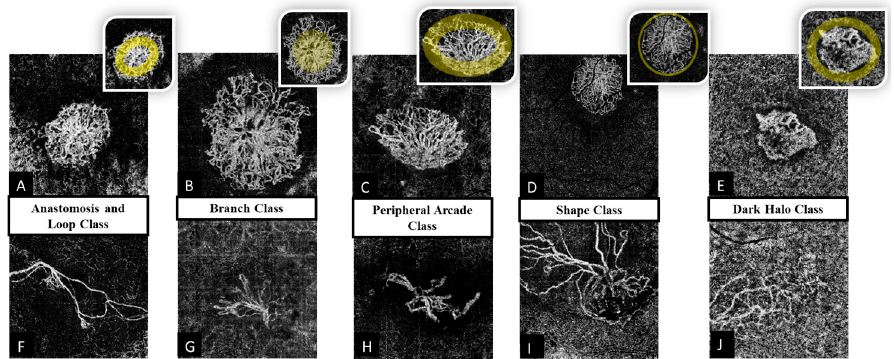
Figure 1. Example of presence (upper row) or absence (lower row: ( F – J )) of five features of CNV activity in ten separate patients. ( A ): anastomosis and loops, ( B ): branching, ( C ): peripheral arcade, ( D ): shape, ( E ): dark halo. Insets show the highlighted region of CNV that de fi ne the feature.